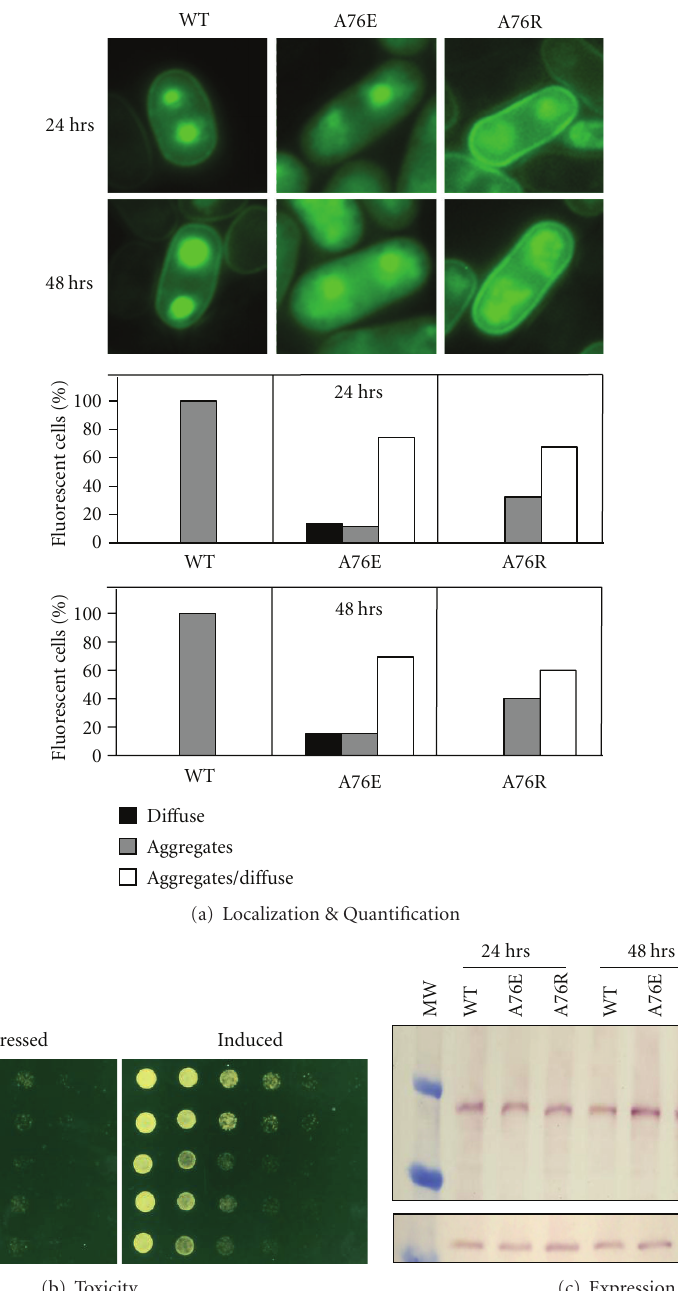
Figure 4: Characterization of alanine-76 in TCP1. (a) Live-cell GFP microscopy of TCP1 cells expressing WT, A76E, or A76R at 24 and 48 hours ( left ). Quantification: ∼ 750 cells of each type were scored for these localization patterns: di ff use, aggregate, and aggregate/di ff use ( right ). Phenotypes were plotted as a percent of total cells that fluoresced ( N = 2). (b) TCP1 cells expressing WT, A76E, or A76R were grown in inducing (EMM − T) media for 48 hours. Vector alone and GFP served as controls. Equal number of cells were serially diluted 5-fold and spotted onto repressing (EMM+T) or inducing (EMM − T) plates and grown for two days ( right ). The A76E and A76R mutants were equally toxic as WT ( N = 3). (c) Western blot of TCP1 cells expressing WT, A76E, or A76R at 24 and 48 hours. Lysates were probed with anti-V5 ( α -synuclein) or anti- β -actin (loading control). Expression is equivalent between WT and the alanine-76 mutants at 24 and 48 hours ( N =